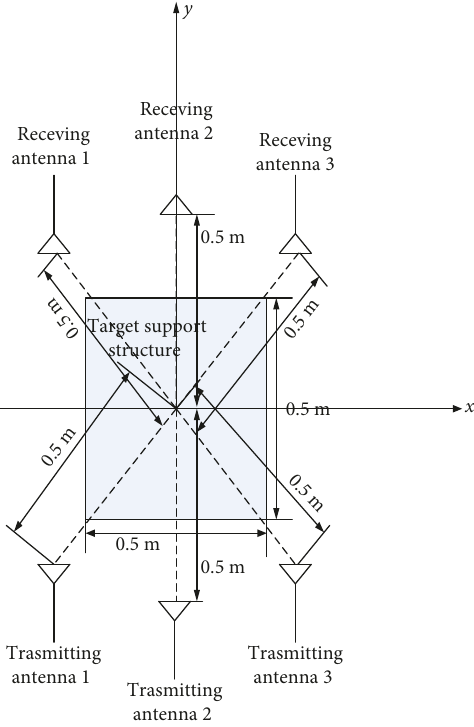
Figure 10: Eight di ff erent states of cuboid candles corresponding to di ff erent Eight di ff erent states of cuboid candles corresponding to di ff erent times can be found in Figure 10.